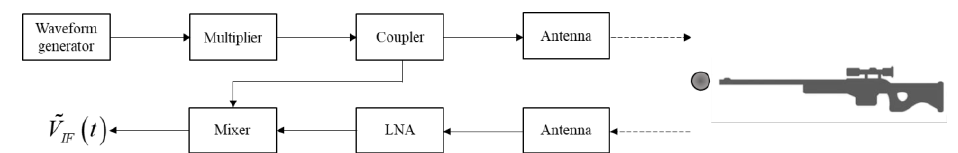
Figure 2. A scheme of the continuous wave micro-Doppler radar.